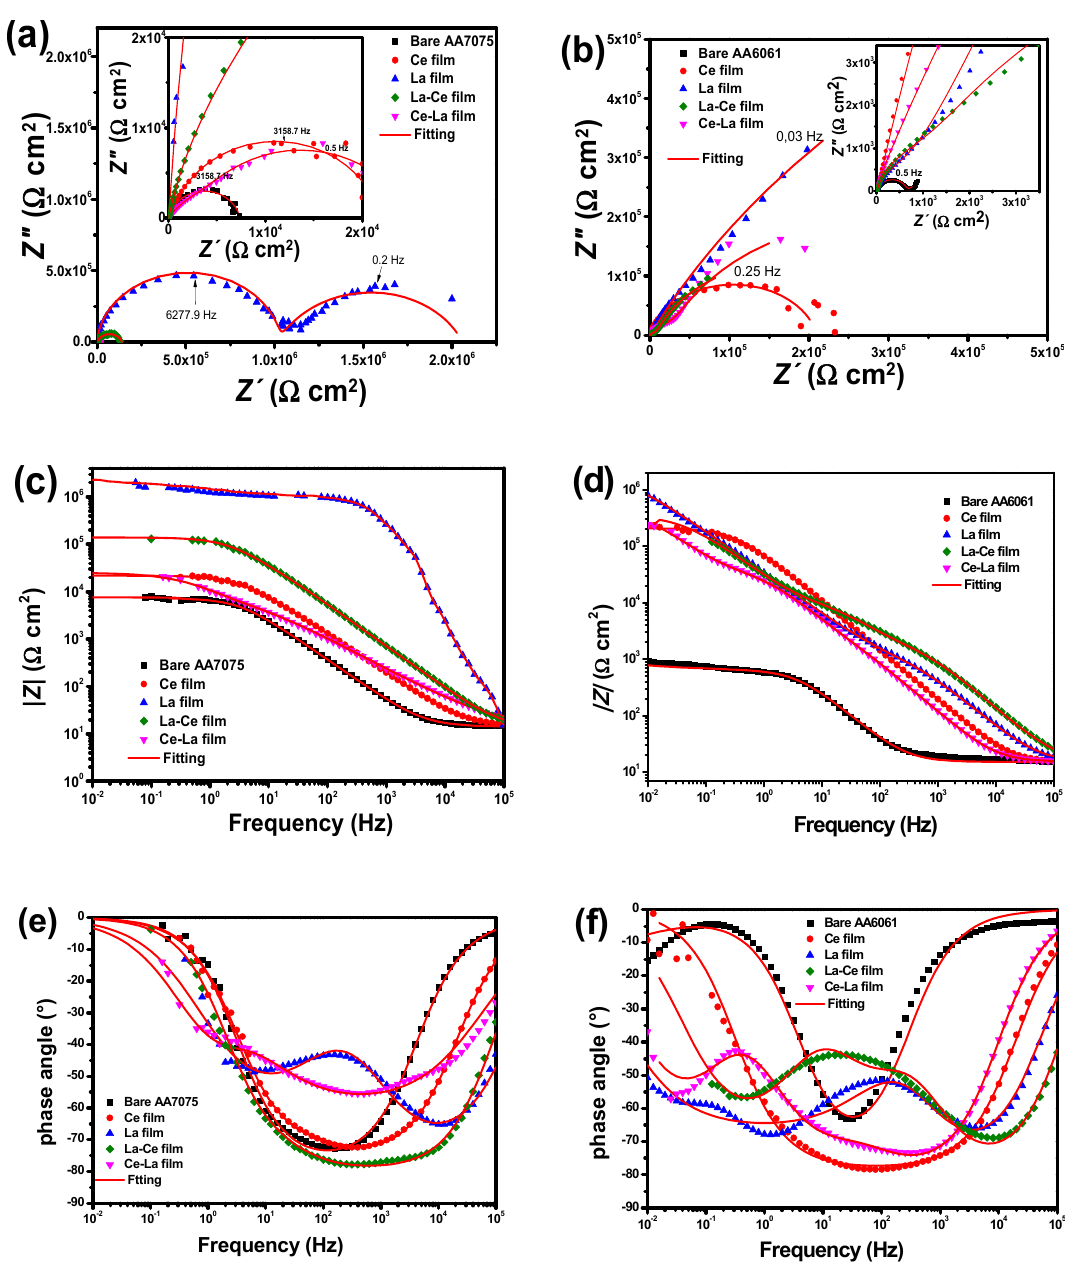
Figure 10. Nyquist and Bode spectra of sputtered coatings on ( a – c ) AA7075 and ( d – f ) AA6061 evaluated in a 3 wt % NaCl solution.